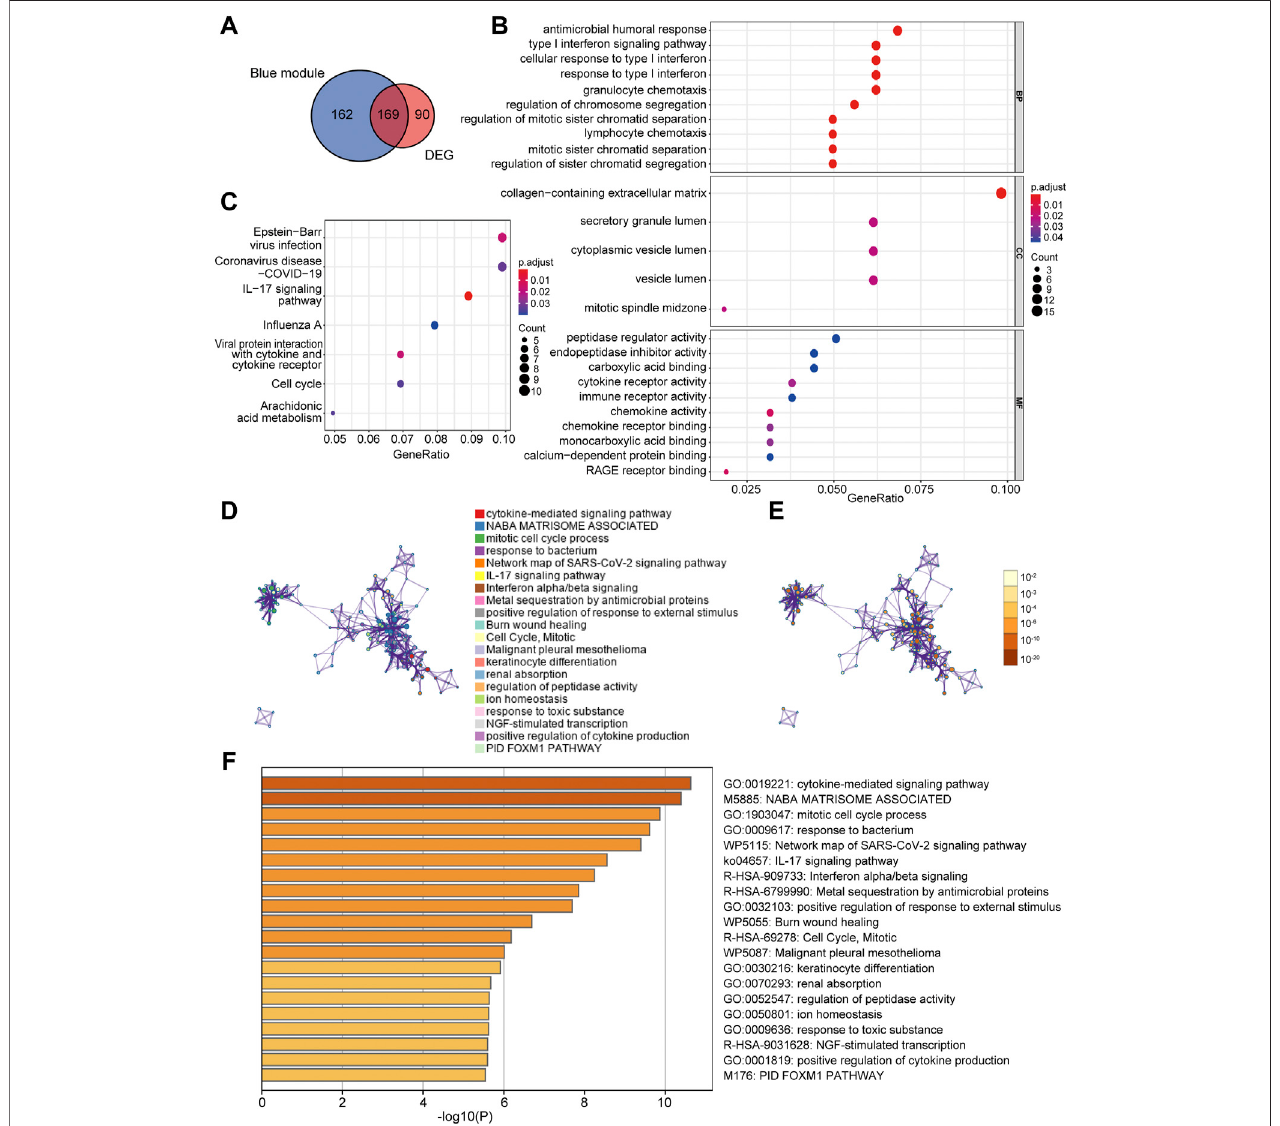
FIGURE 4 | Determination of co-DEGs and functional enrichment analysis. (A) Venn diagram illustrating the co-DEGs screened from the intersection of the DEGs and the module genes with AD traits. (B) Remarkably enriched GO terms of co-DEGs. (C) Remarkably enriched KEGG cascades of co-DEGs. (D) Network illustrating terms occurring abundantly in co-DEGs. Every node designates an enriched term colored based on its cluster identity. (E) The same enriched network with nodes colored via p -value. (F) The top 20 pathways linked to co-DEGs based on a comprehensive enrichment assessment. co-DEGs, common differentially expressed genes; AD, atopic dermatitis; GO, gene ontology; KEGG, Kyoto encyclopedia of genes and genomes.